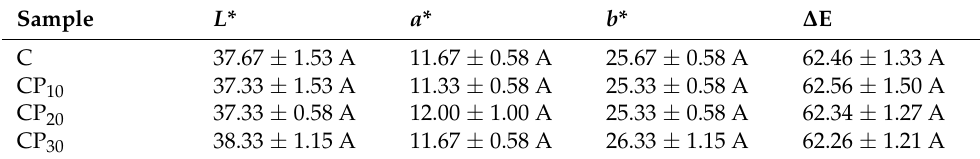
Table 1. Color parameters of various BSG